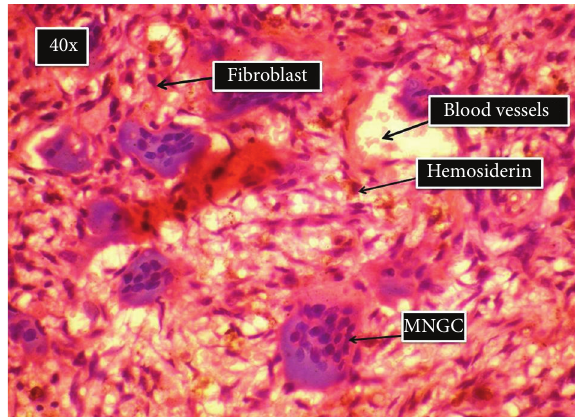
Figure 6: Histologic section showing connective tissue stroma, proliferating fibroblast, multinucleated giant cells, and interspersed hemosiderin pigment.